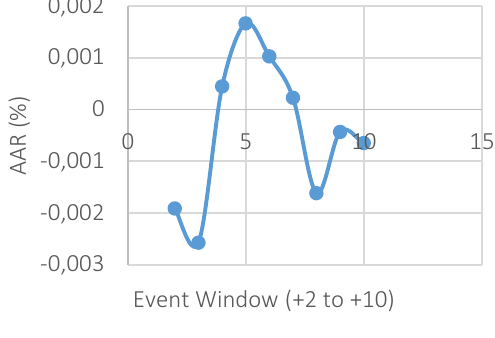
Figure 10. Average abnormal returns for the period of (+2, +5) days